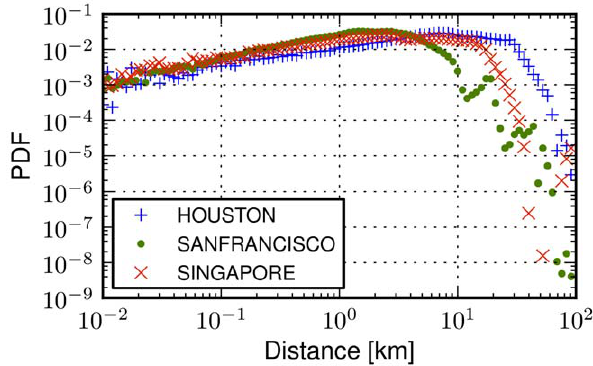
Figure 12. Effect of place coordinate randomization on the performance of the rank-distance model. On the y-axis we present the KL-divergence, D KL ( H DD R ) , between the empirically observed distribution of displacements in a city H and R which is the one obtained by the rank-distance model. On the x-axis the probability of randomization, P rand , is depicted. In order to randomize the spatial distribution of places in a city, we iterate through the associated set of places U and the coordinates of a place u , ( lat u , long u ) are randomized with probability P rand . A new pair of coordinates, ( lat u ’ , long u ’ ) , is assigned uniformly and within a pre-specified range, where lat u ’ [ ½ lat u + 0 : 1 (cid:2) and long u ’ [ ½ long u + 0 : 1 (cid:2) . P rand ~ 0 corresponds to the case that the original distribution of displacements within a city is maintained, whereas the opposite extreme where P rand equals 1 : 0 means that all places have been randomized. The errors bars correspond to standard deviations across cities.